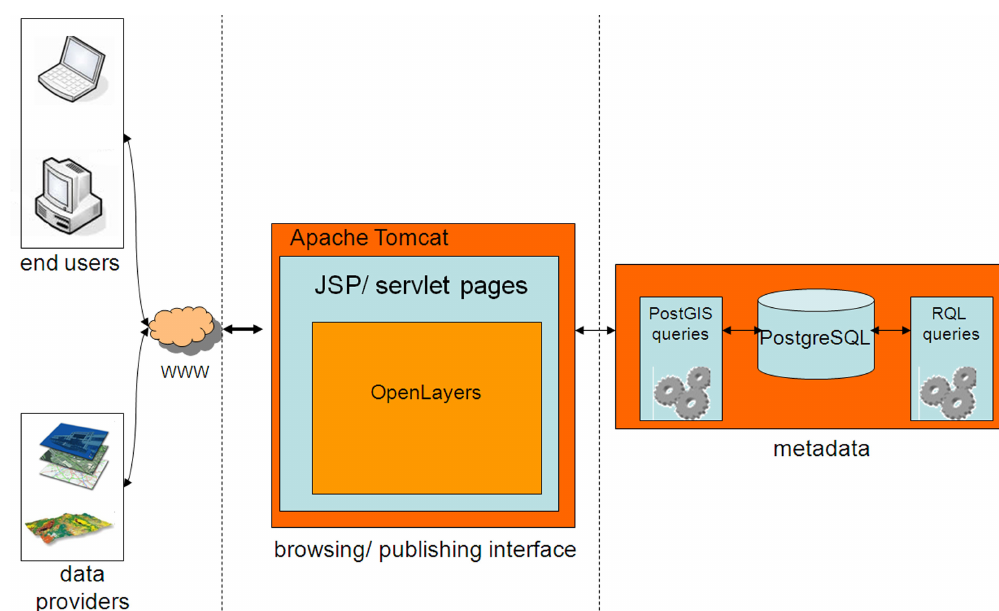
Fig. 14. The architectural design of